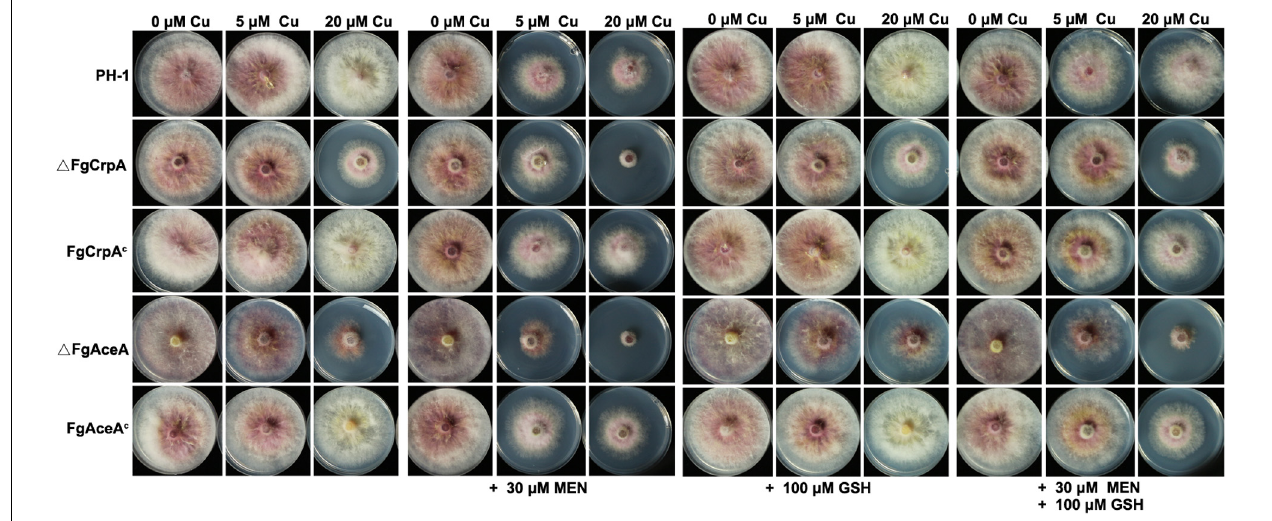
FIGURE 5 | Reduced Cu tolerance caused by FgAceA or FgCrpA deletion aggravates ROS sensitivity in F. graminearum . Growth of F. graminearum strains on Cu-containing FMM media added with supplements (menadione, MEN and/or L -glutathione, GSH) at various concentrations as indicated at 25 ◦ C for 4